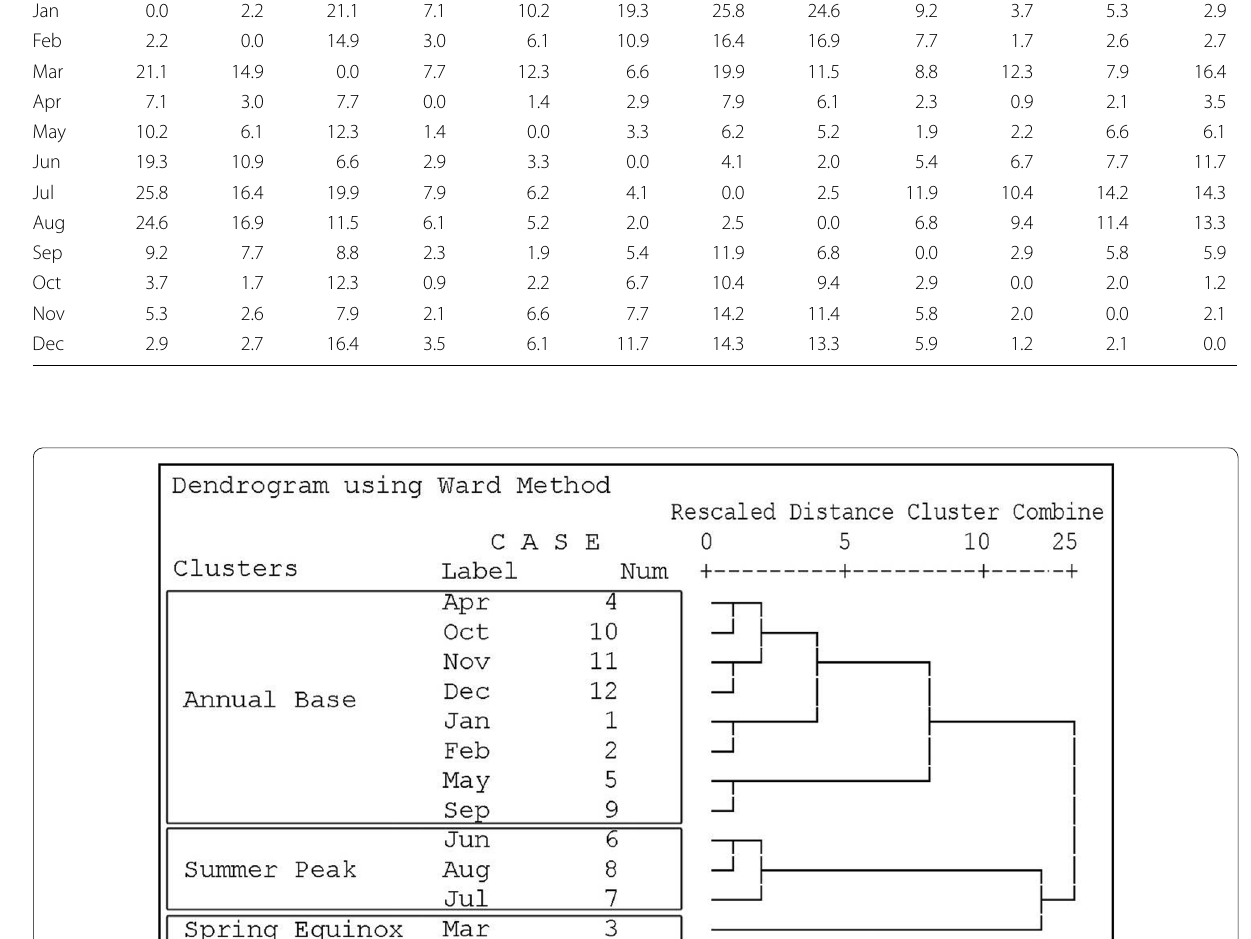
three independent variables were selected, including climatic comfort indicator of the effective temperature (ET), temperature inversion indicator of environmental lapse rate (ELR), and temporal indicator of local calendar events. All aforementioned variables, by diurnal, weekly, and monthly scales, were summarized averagely to ana- lyze, acquiring correlation analysis. The highest and lowest diurnal traffic flows were observed for August and January months with a mean frequency of 63,792 and 43,673 vehicles, respectively. Averagely, about 66,400 and 54,300 vehicles were recorded for the mean daily frequency of traffic flow at each weekday and Friday in 2018, respectively. Based on the temporal cycles of weekends and vacations, a